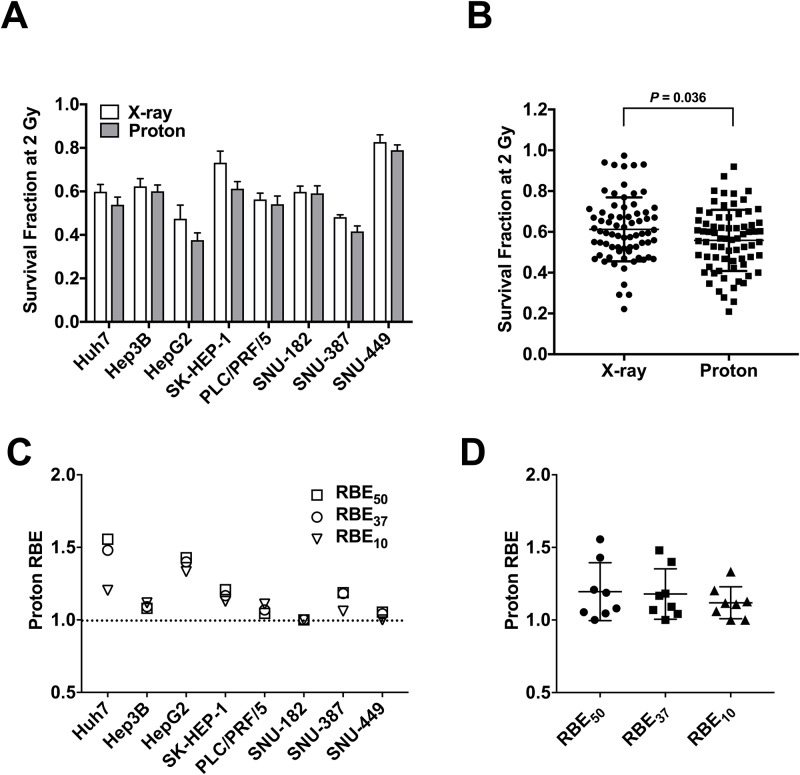
Radiation sensitivity and proton RBEs differ largely in HCC cell lines.(A) Bar graph shows variability of radiosensitivity of eight HCC cell lines. Radiosensitivity was compared as survival fractions at 2 Gy (SF2) of X-ray and proton irradiation. Data represent mean ± SD from three independent experiments. (B) Column scatter plot shows that protons were more effective than X-rays in HCC cells (p < 0.05). (C) Comparison of RBEs of eight HCC lines at survival fractions of 50% (RBE50), 37% (RBE37), and 10% (RBE10). The dashed line indicates RBE of 1.0. (D) Summary of proton RBEs in HCC cell lines. The box-and-whisker plot indicates averaged RBE values of approximately 1.1, regardless of biological end points.